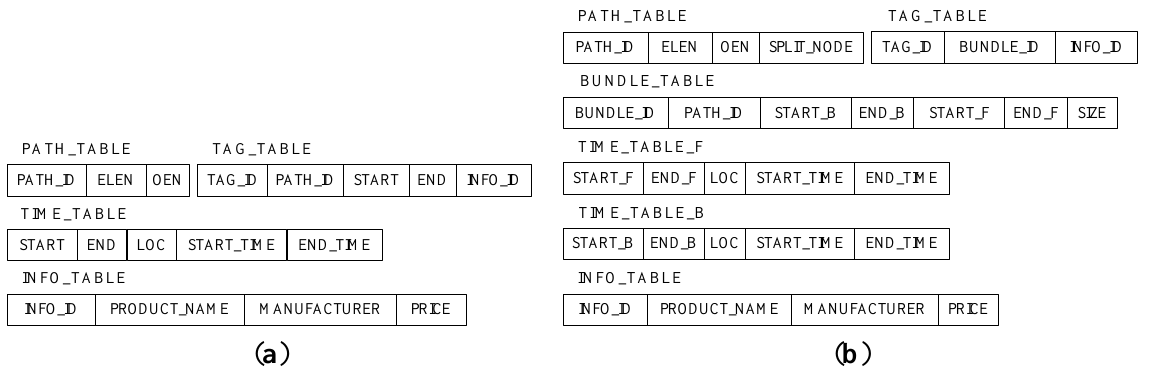
Figure 3. ( a ) Original relational schema; ( b ) New relational schema to store RFID